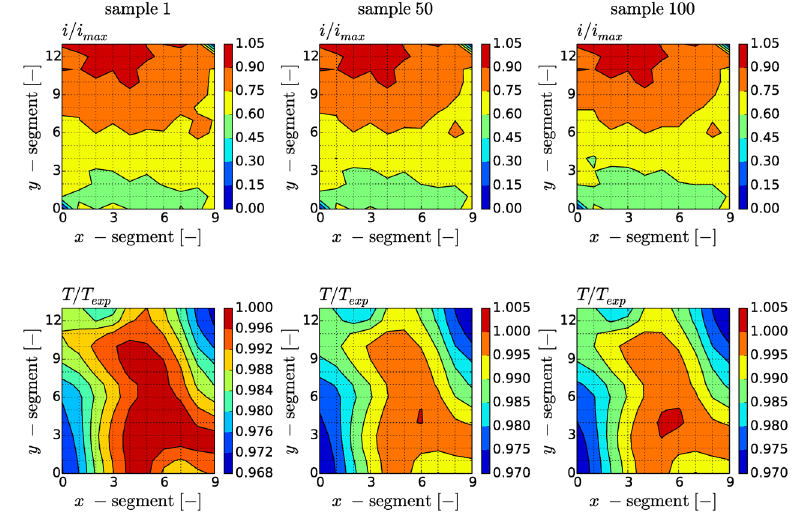
Fig. A3. Distribution of the current density and temperature at maximal load in the AST - F100.